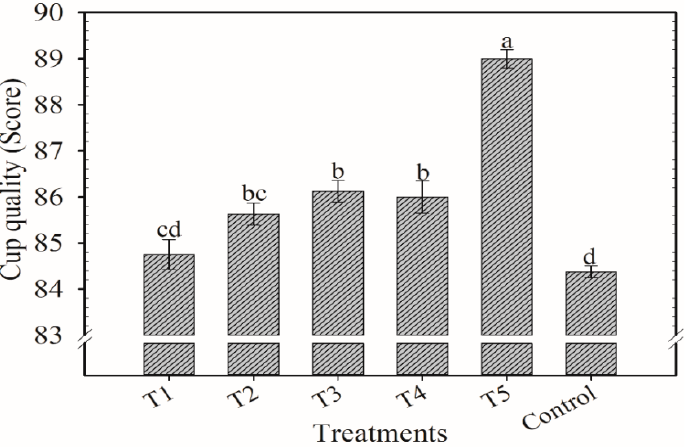
Figure 8. Scores of the cup quality of coffee beans at cherry stage after application of blends of KCl e K 2 SO 4 as cover fertilization. Harvest of 2019/2020. Means followed by the same letter in the column do not differ according to Tukey’s test ( p < 0.05). Vertical bars indicate the standard error of the mean ( n = 4). T1: 100% KCl; T2: 75% KCl + 25% K 2 SO 4 ; T3: 50% KCl + 50% K 2 SO 4 ; T4: 25% KCl + 75% K 2 SO 4 ; T5: 100% K 2 SO 4 ; control did not receive K 2 O. Table 3. Variables analyzed in the coffee beans for the harvest of 2019/2020.